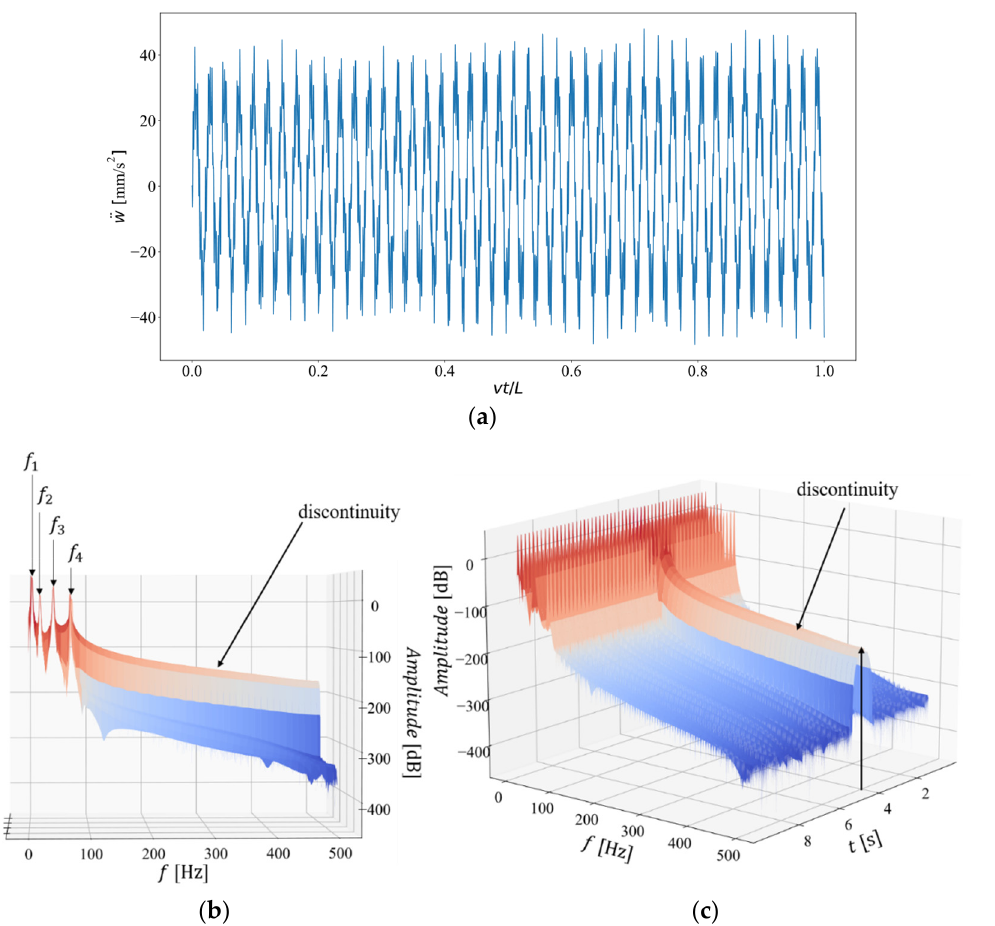
Figure 7. Simply-supported beam with a vertical crack of length 𝛼 = 25 mm at station 𝐿 (cid:2869) = 2.00 m traversed by a point force 𝑃 with constant velocity 𝑣 : ( a ) Acceleration time history 𝑤(cid:4663) (mm/s (cid:2870) ) at station 𝐿 (cid:2869) = 2.00 m , ( b ) Fourier transformed acceleration amplitude 𝑊(dB ) showing the first four eigenfrequencies 𝑓 (cid:3036) (Hz) and ( c ) Time-frequency spectrum of the acceleration amplitude 𝑊(dB ) showing a discontinuity at time 𝑡 = 4 s . Note that colors indicate energy intensity in the signal.